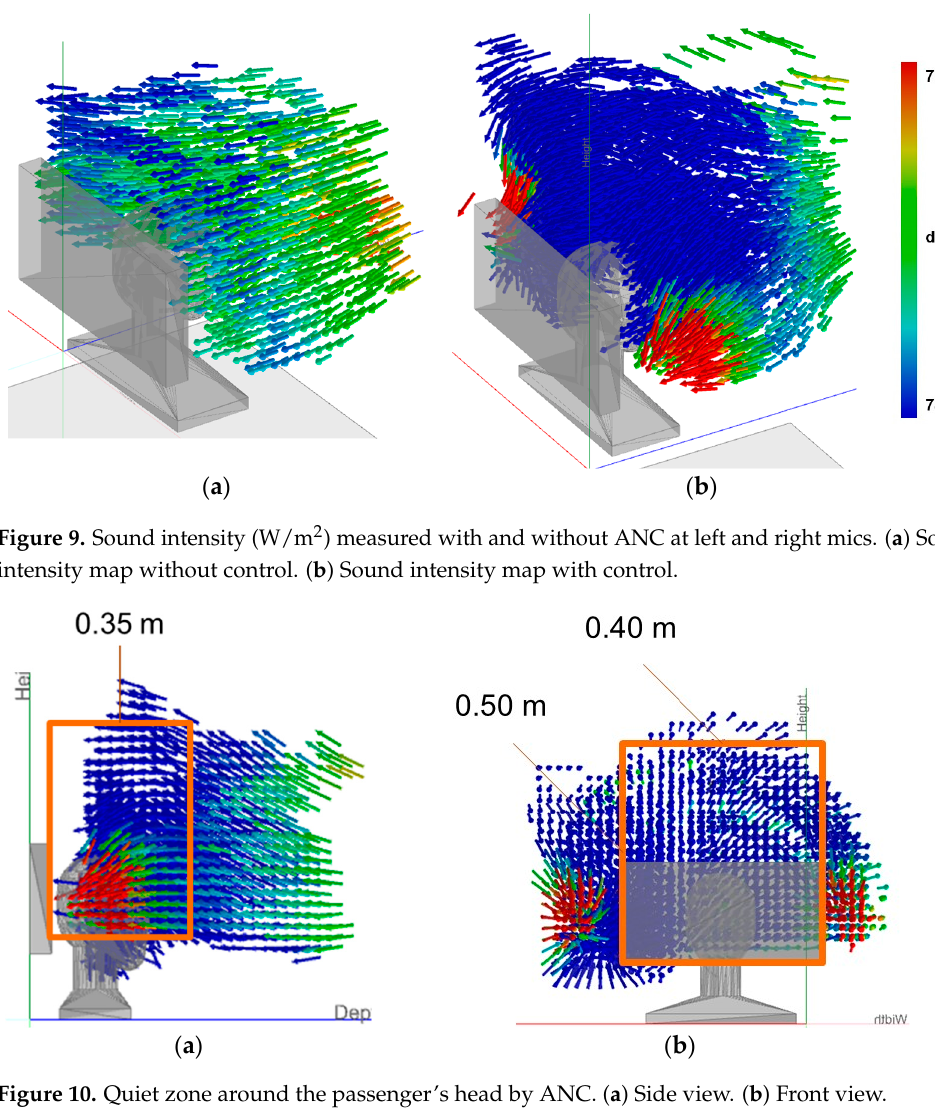
Figure 10. Quiet zone around the passenger’s head by ANC. ( a ) Side view. ( b ) Front